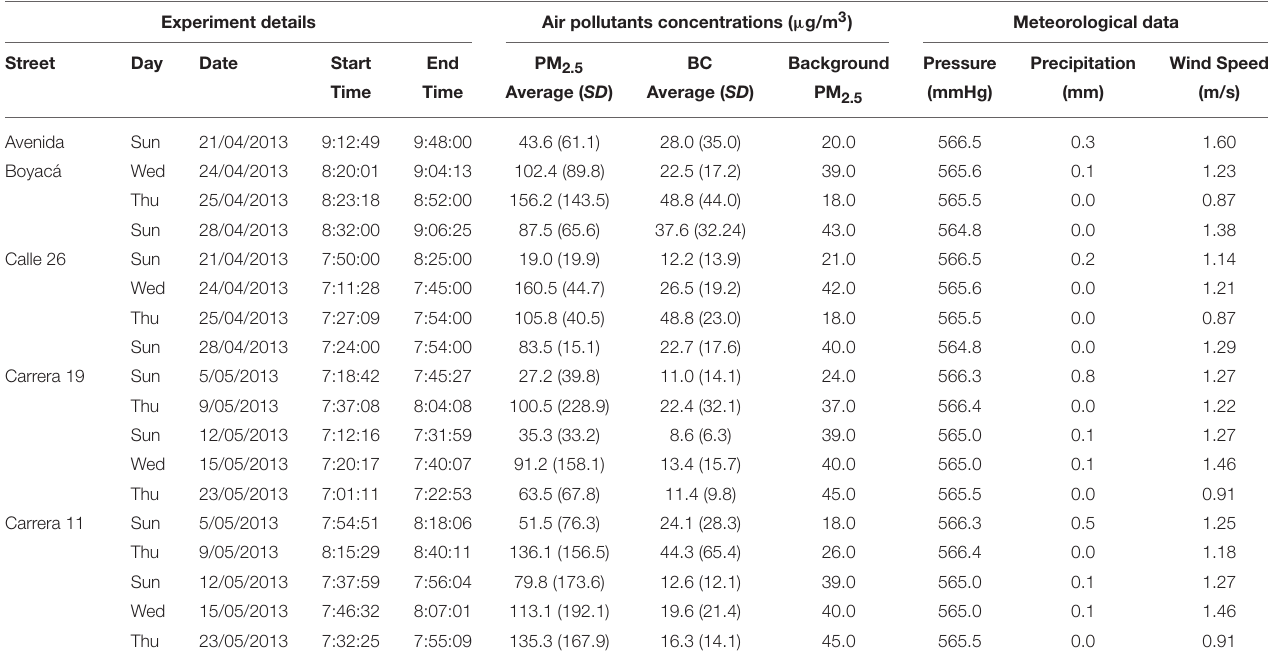
TABLE 2 | Summary of the field data, pollutant levels and meteorological